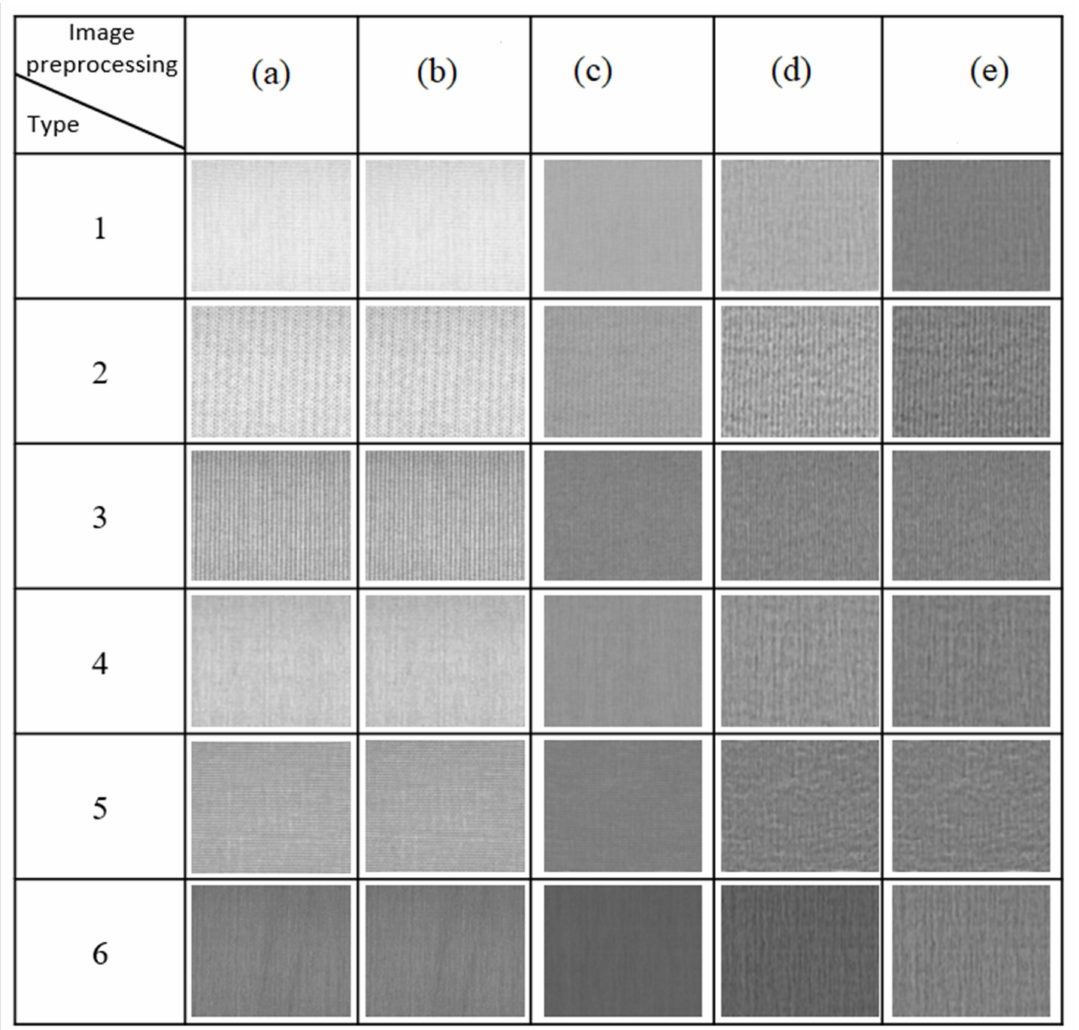
Figure 10. The image preprocessing demonstration: ( a ) Grayscale image; ( b ) Filtering image; ( c ) Brightness correction; ( d ) Contrast upgrade; ( e ) Average